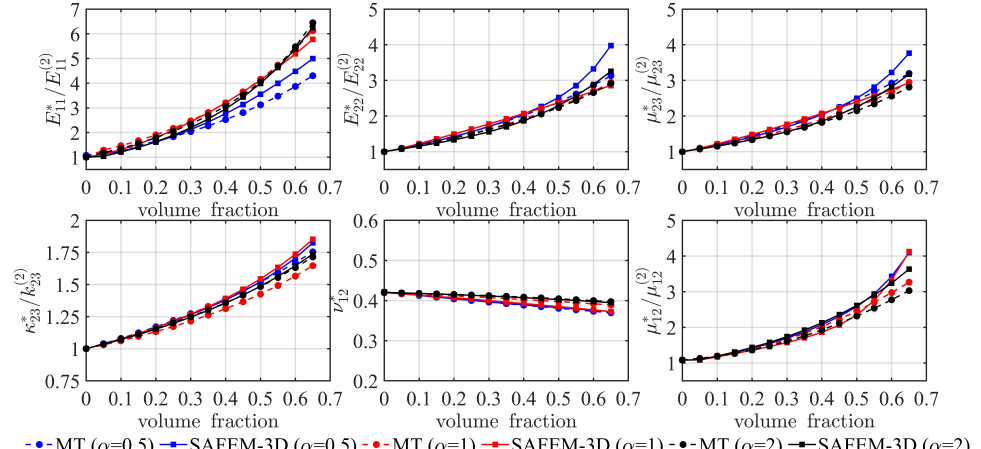
Figure 3. Elastic effective coefficients of two-phase composite (graphite/epoxy) for three different aspect ratios: α = 0.5 (discs), α = 1 (spheres) and α = 2 (ellipsoids). MT: Mori–Tanaka method; SAFEM-3D: three-dimensional semi-analytical finite element